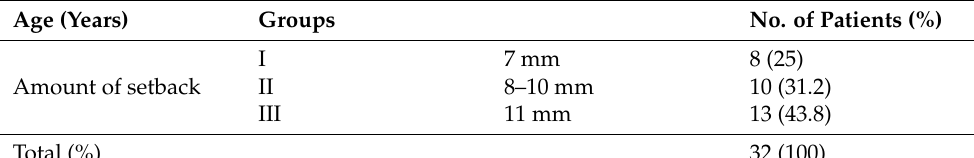
Table 2. Number of patients according to amount of setback.